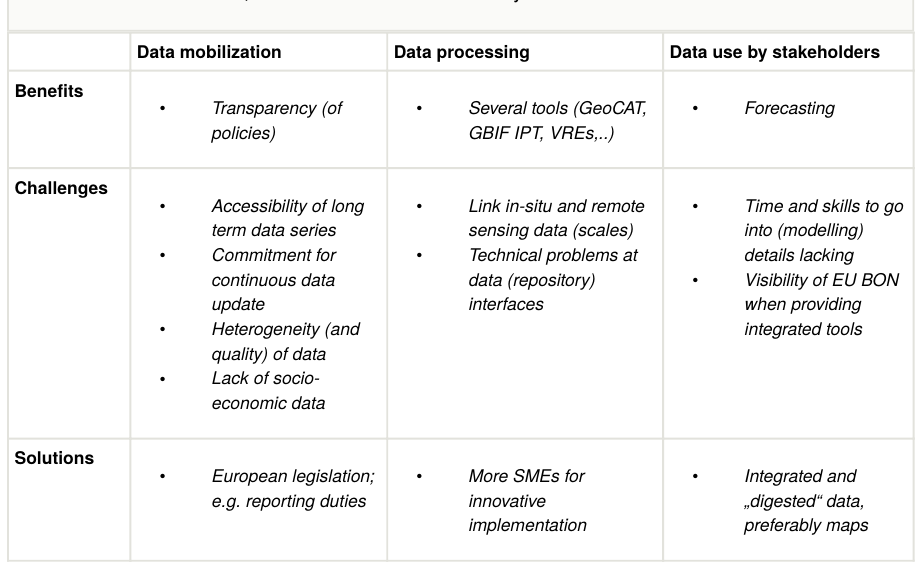
Table 1. Data work fl ow framework, fi lled with content from 1st